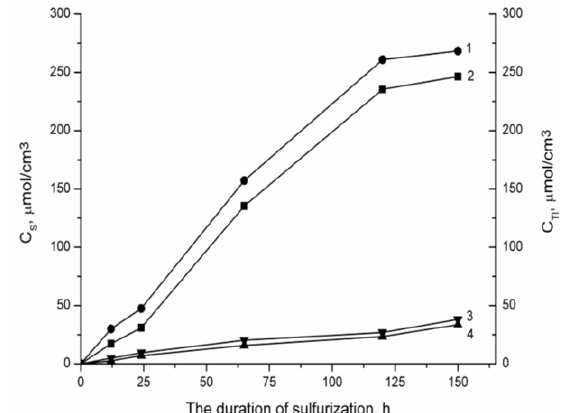
Figure 1. Changes of sulfur (curves 1 and 2) and thallium (curves 3 and 4) concentrations in the Tl